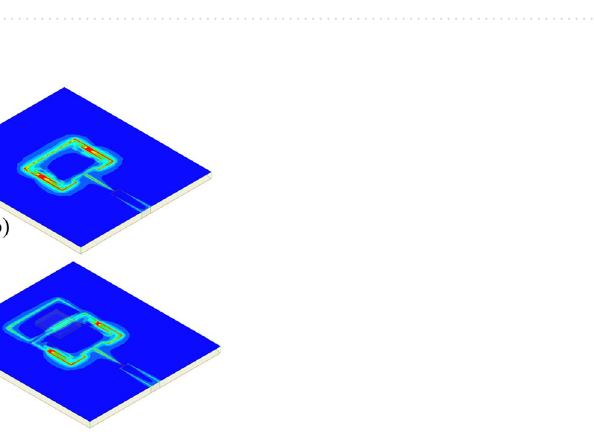
Figure 2. ( a ) Reflection coefficient of simulated antenna for three consecutive design steps. ( b ) Reflection coefficient of simulated antenna for bare, water, and ice scenarios.